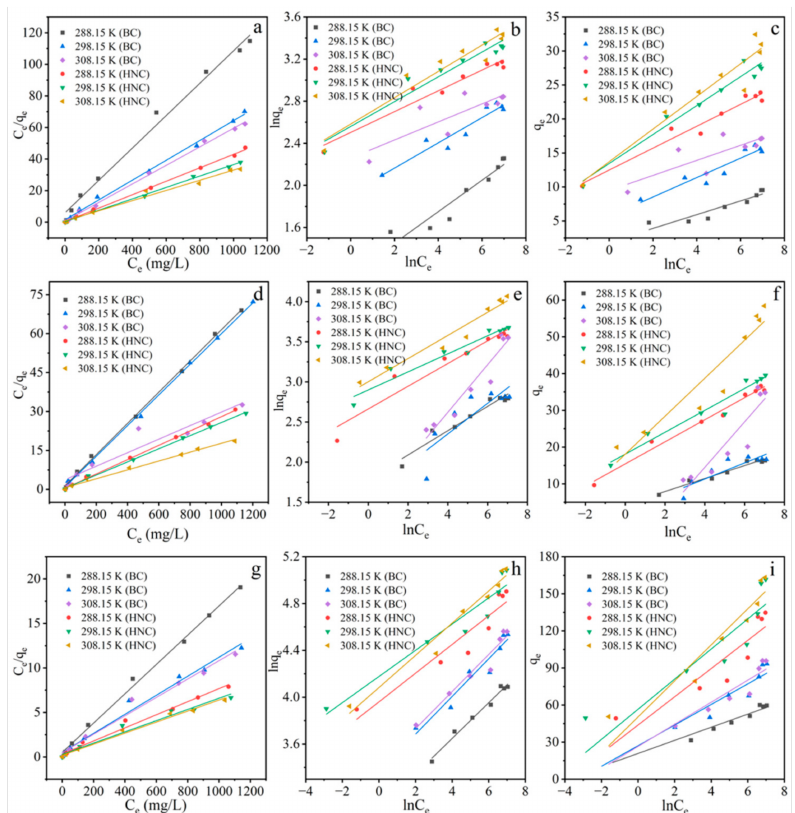
Figure 5. Langmuir, Freundlich and Temkin isotherm fitting of Cu 2+ ( a – c ), Cd 2+ ( d – f ) and Pb 2+ ( g – i ) adsorption by BC and HNC; dosage of 2 g/L (Cu 2+ , Cd 2+ ) and 1 g/L (Pb 2+ ); pH of 5.5; time of 240 min and temperature of 288.15, 298.15 and 308.15